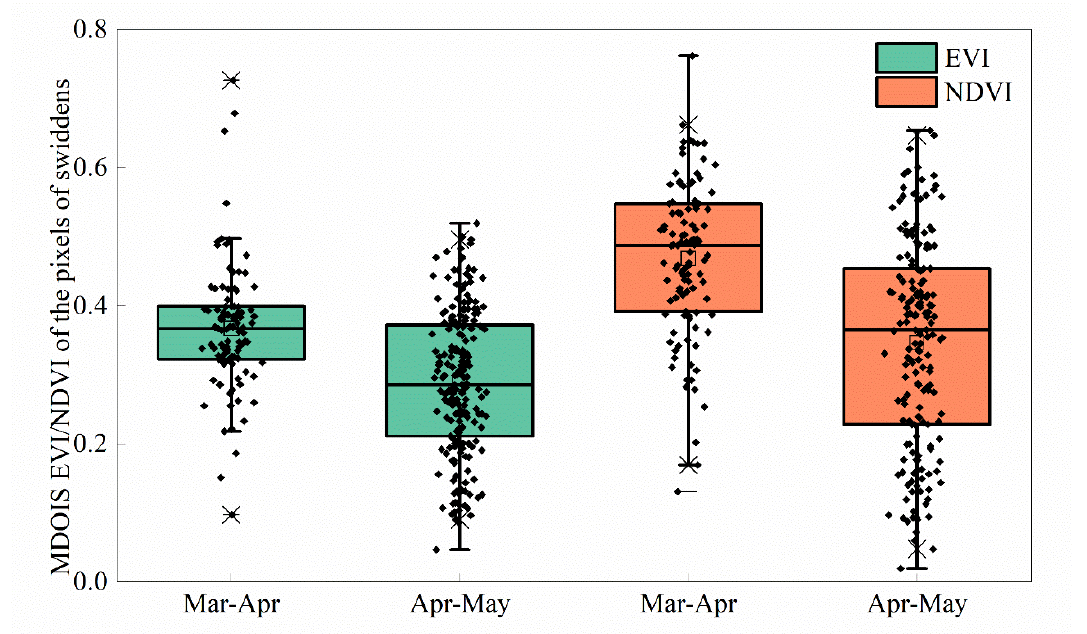
Figure 4. Box plots of MODIS NDVI and EVI of newly opened swiddens in March – April and April – May during 2001 – 2020. Table 2. Validation results of swidden agriculture landscape (SAL) via confusion matrix based on Landsat